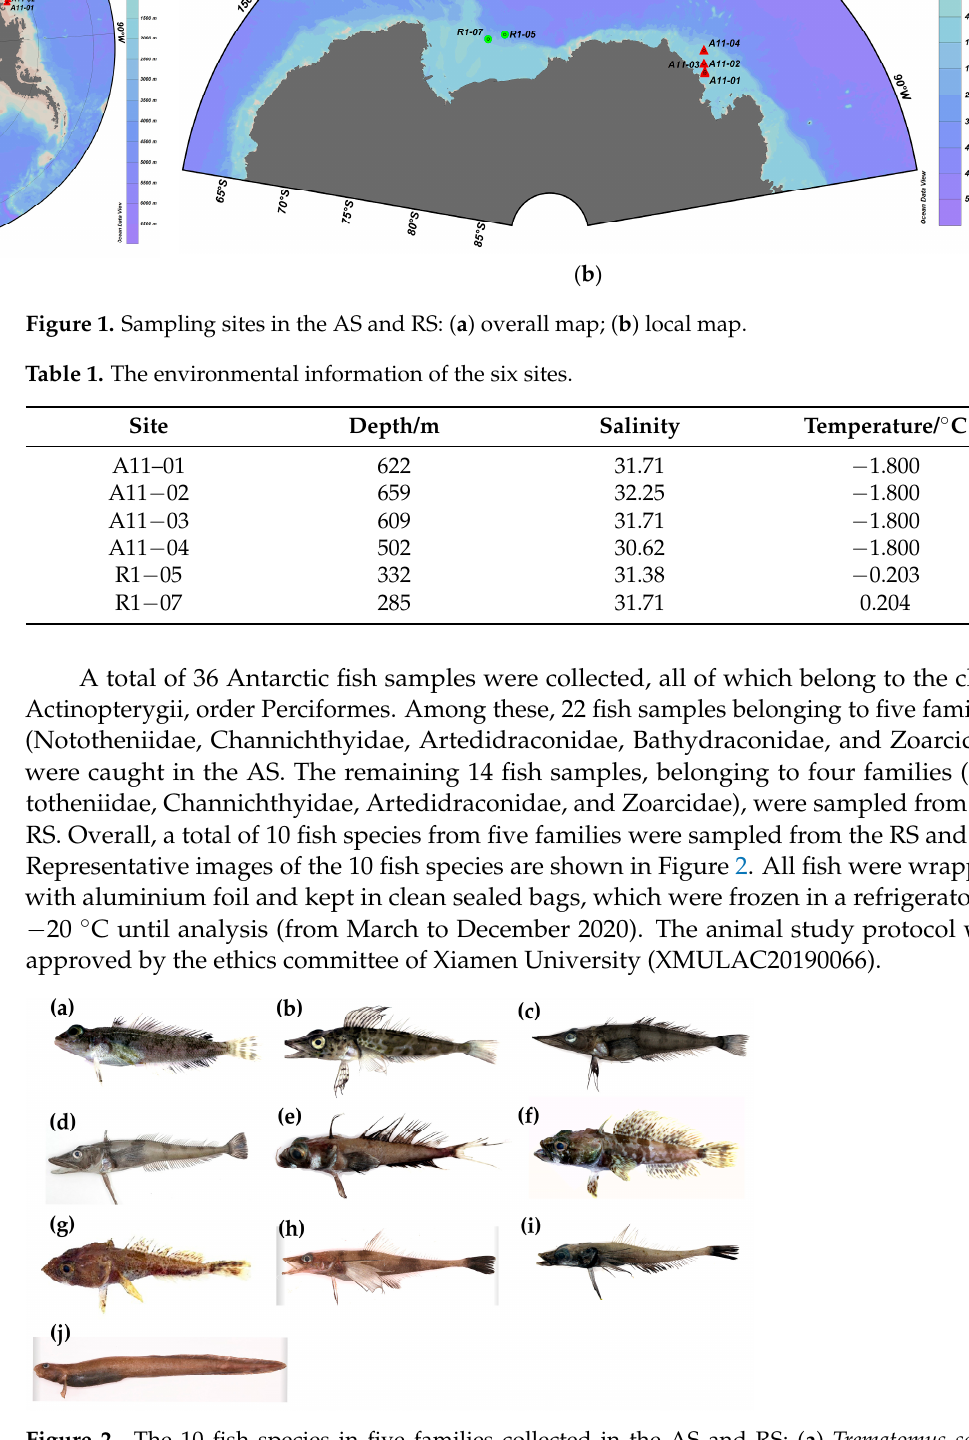
Figure 2. The 10 fish species in five families collected in the AS and RS: ( a ) Trematomus scotti ; ( b ) Pagetopsis maculatus ; ( c ) Dacodraco hunteri ; ( d ) Chionodraco myersi ; ( e ) Dolloidraco longedorsalis ; ( f )